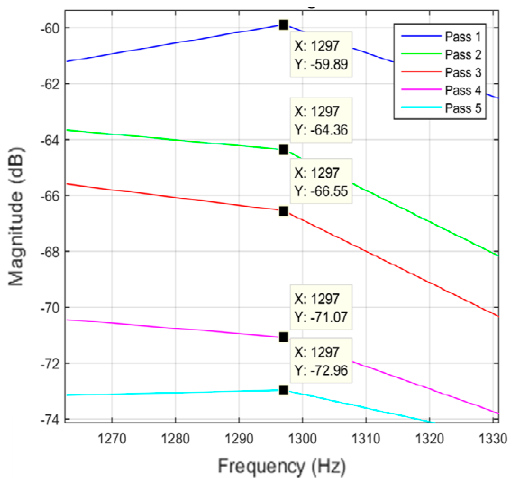
Figure 14. Vibration signal in Z direction.